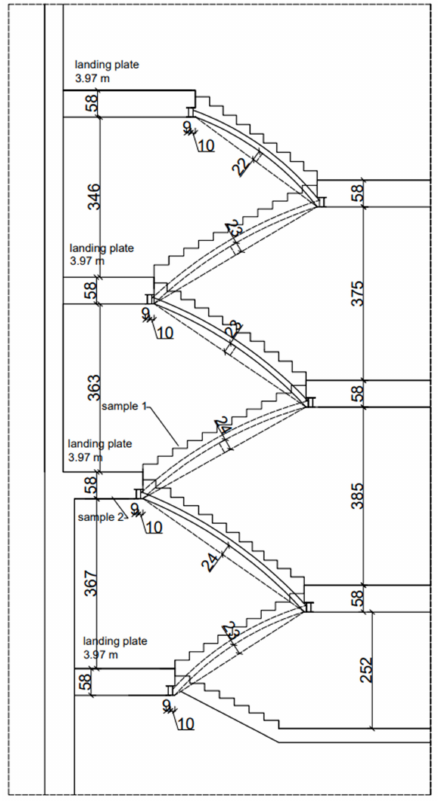
Figure 6. A view of K5